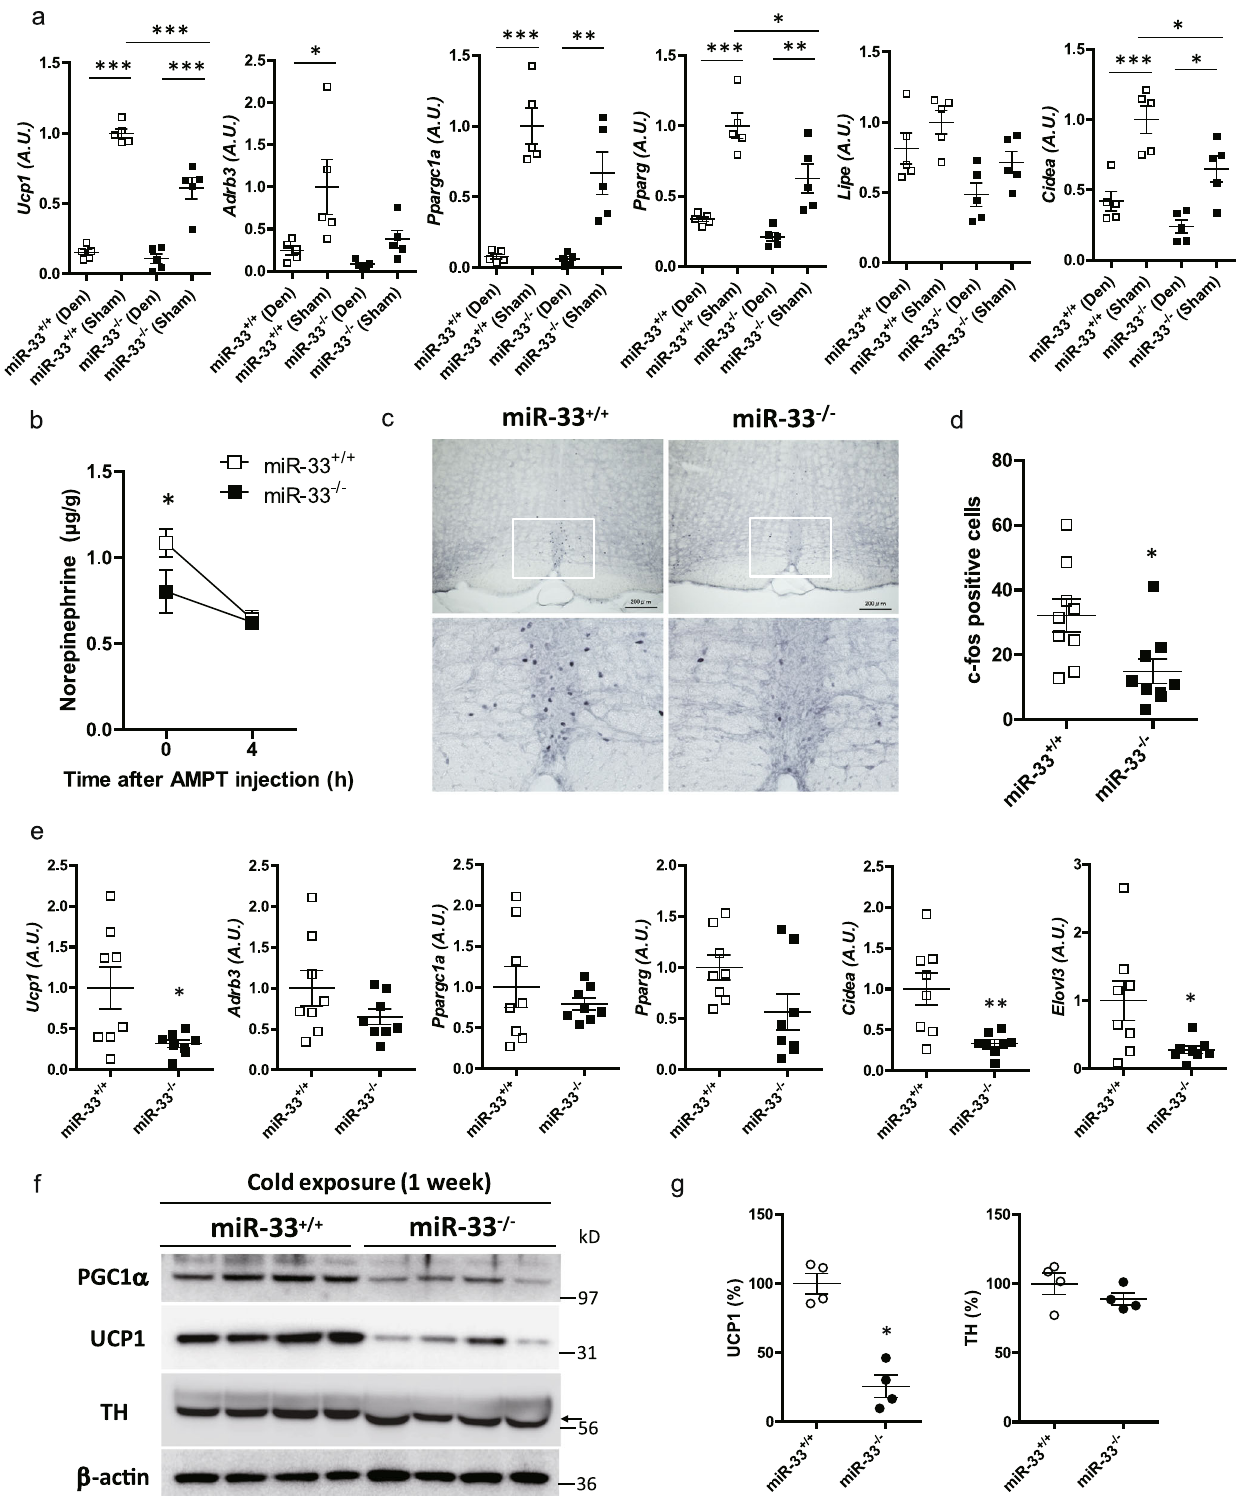
(Fig. 5c). At the age of 8 weeks, miR-33 f/f DBH -Cre mice and their littermate control mice (miR-33 f/f mice) were placed into a 4 °C environment for 5 h. Core body temperature decreased faster in miR-33 f/f DBH -Cre mice than in the control mice (Fig. 5d). His- tological analyses showed that many more lipid droplets remained in miR-33 f/f DBH -Cre mice kept in a 4 °C environment for 5 h (Fig. 5e and Supplementary Fig. 8c). NETO in the BAT was